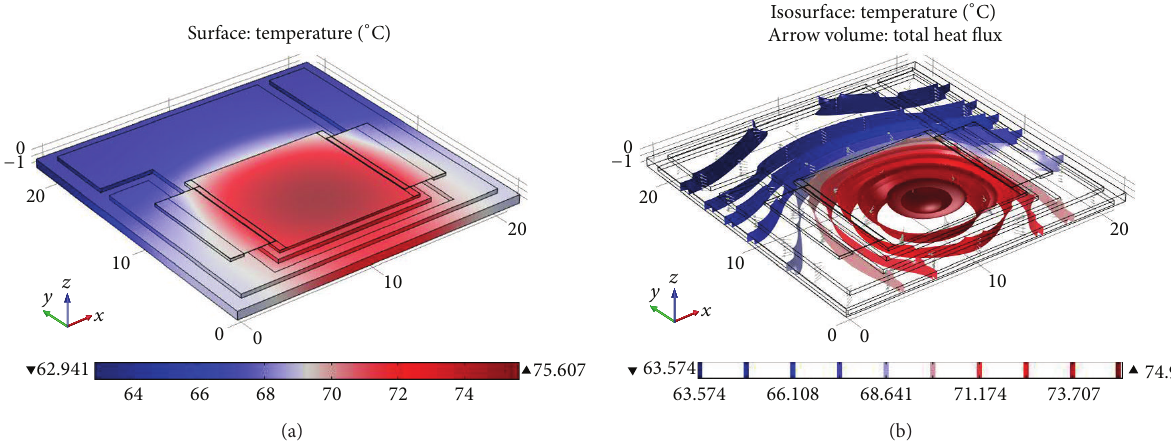
Figure 5: Temperature distribution (a) and isothermal contours (b) in the DBC based assembly, in ∘ C. Max cell’s temperature: 75.6 ∘ C.